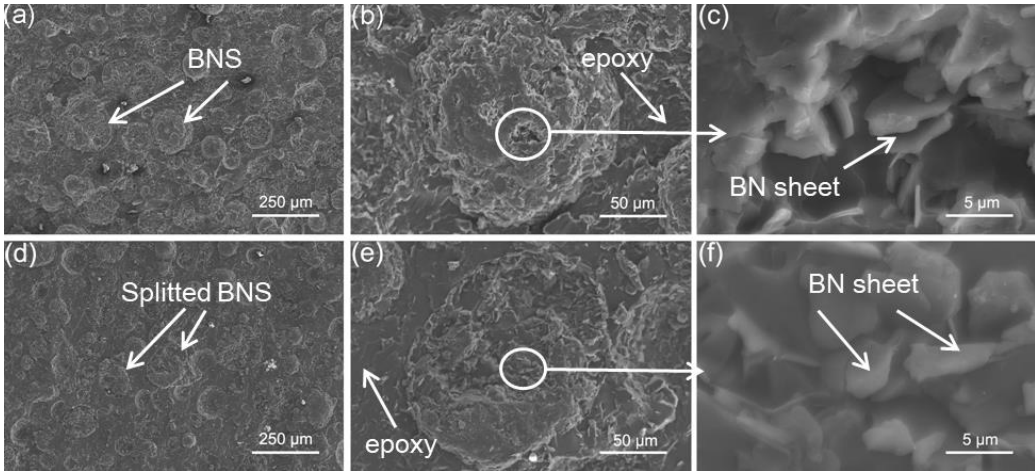
Polymers 2019 , 11 , x FOR PEER REVIEW Figure 2. Cross-sectional SEM images of the epoxy/BNS composites with different BNS loading fractions. Figure 2. Cross-sectional SEM images of the epoxy / BNS composites with di ff erent BNS loading fractions.